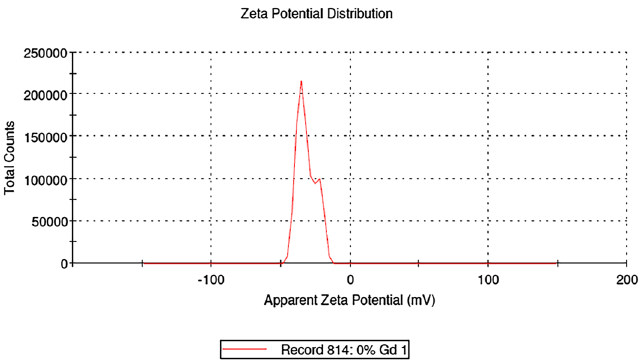
Figure 10. Zeta potential of DIP proniosomal gel-derived niosomes.